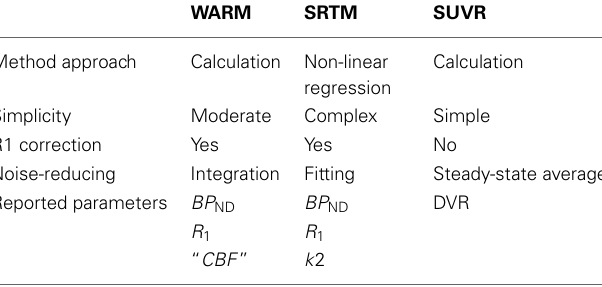
Table 6 | Characteristic feature of the three methods